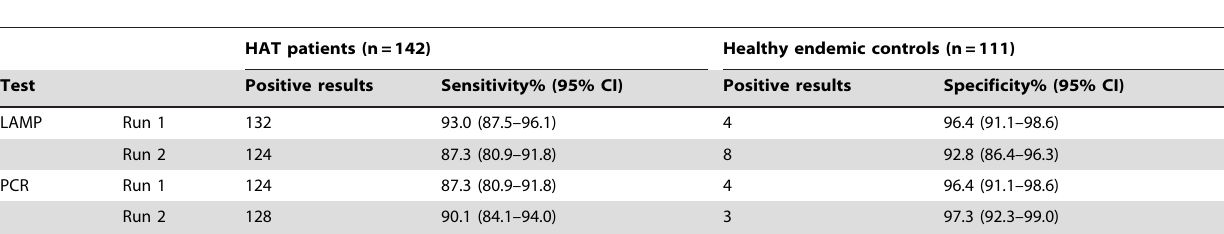
Table 1. Sensitivities and specificities of replicate RIME LAMP and 18S PCR on the blood of HAT patients and healthy endemic